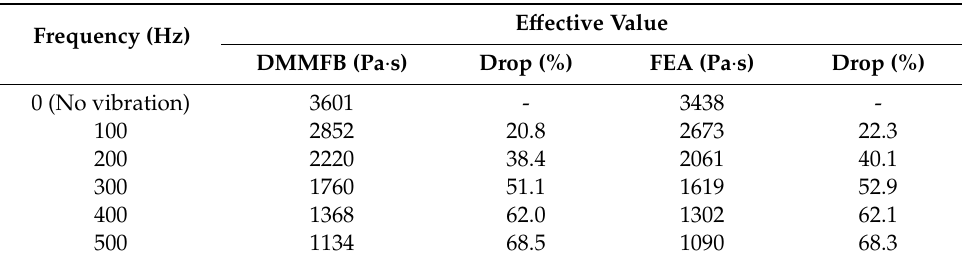
Table 9. E ff ective value of the apparent viscosity without and with 0.25 g vibration applied at di ff erent frequencies.